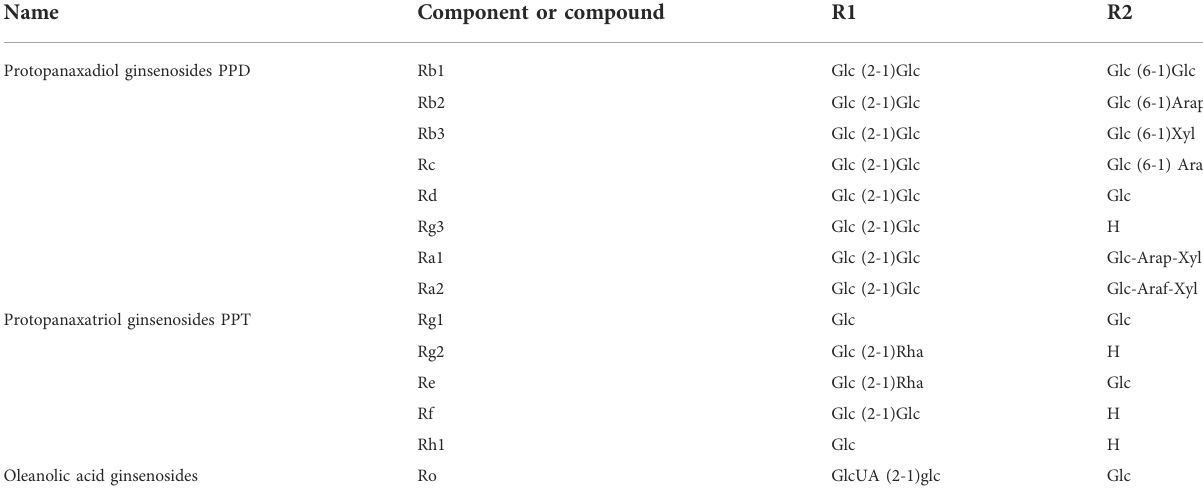
TABLE 1 Chemical structure classi fi cation of ginsenoside components.